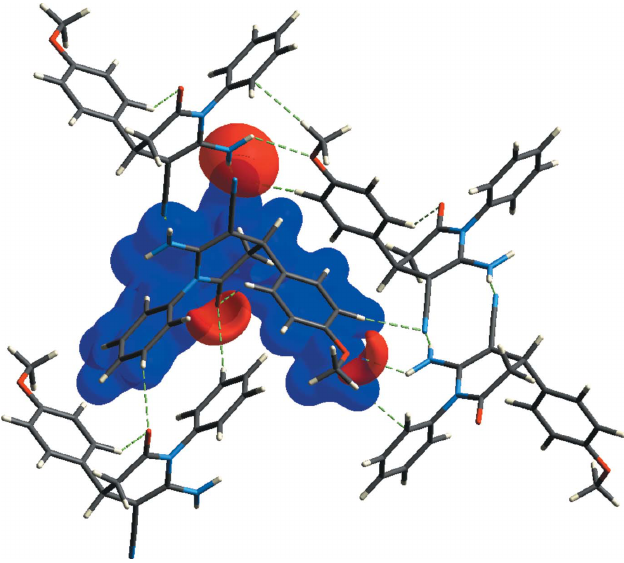
Figure 7 View of the three-dimensional Hirshfeld surface of the title compound, showing the hydrogen-bonding interactions, plotted over electrostatic potential energy in the range (cid:4) 0.0500 to 0.0500 a.u. using the STO-3 G basis set at the Hartree–Fock level of theory. Hydrogen-bond donors and acceptors are shown as blue and red regions, respectively, around the atoms, corresponding to positive and negative